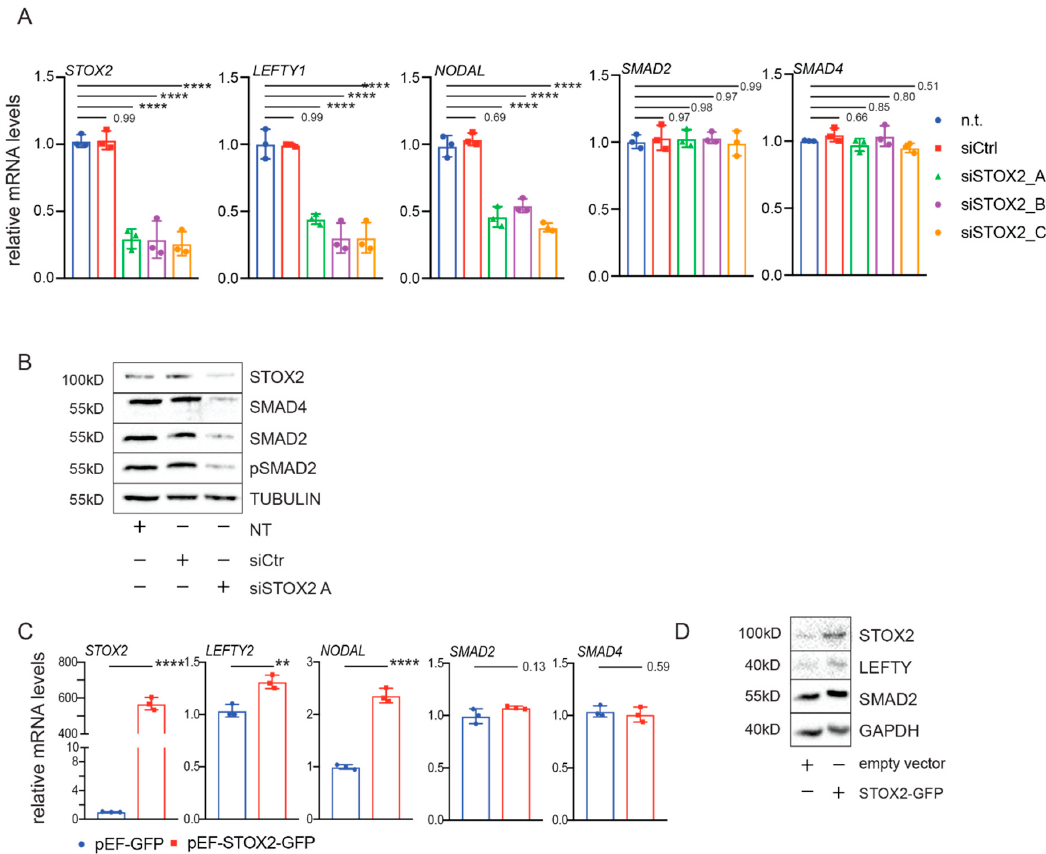
Figure 4. STOX2 misregulation impacts the expression of TGF- β target genes. ( A ) siRNA-mediated knock-down of STOX2 in hESCs (H1). H1 cells were transfected with siRNA targeting STOX2; sictr and mock treated cells served as control. After 48 h, pellets of cells were collected and mRNA expression levels of STOX2, LEFTY1, NODAL, SMAD2 and SMAD4 were determined. Relative mRNA levels to GAPDH and HPRT were calculated using the ΔΔ Ct method. (N = 3, average ± SD, p -value **** < 0.0001, ordinary 2-Way ANOVA, Dunnett’s multiple comparisons). ( B ) Immunoblot analysis with antibodies against STOX2, SMAD4, SMAD2 and pSMAD2 was performed in hESCs (H1) treated as in ( A ). Staining of the membranes with TUBULIN antibody ensured equal loading. Representative images of three independent experiments are shown. ( C ) Overexpression of STOX2-GFP in hESCs (H1). Stable cell lines over expressing STOX2 were generated, and mRNA expression levels of STOX2, LEFTY2, NODAL, SMAD2, and SMAD4 in hESCs stably overexpressing STOX2-GFP were determined by RT-qPCR and relative mRNA to GAPDH and HPRT levels calculated using the ∆∆ Ct method. (N = 3, average ± SD, p -value ** < 0.01, **** < 0.0001 unpaired t-test, two tailed). ( D ) Immunoblot with antibodies directed against STOX2, LEFTY1 + 2 and SMAD2 in hESCs (H1) overexpressing STOX2-GFP as in ( C ). Probing the membranes with antibodies against GAPDH ensured equal loading. Representative images of three independent experiments are